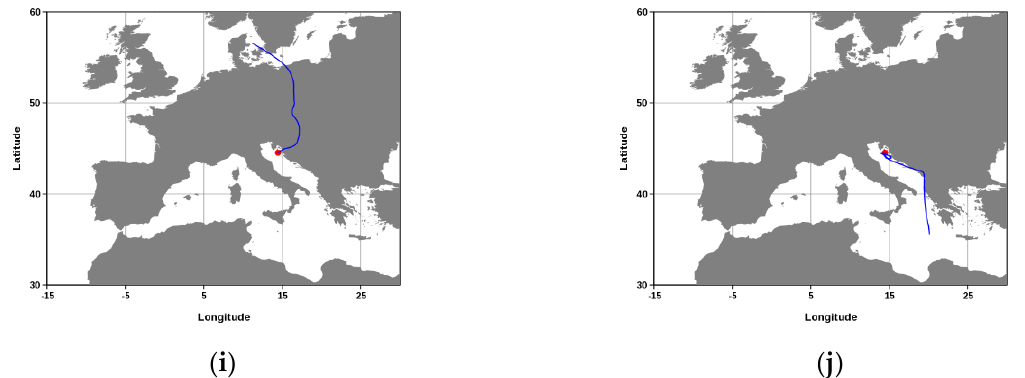
Figure 5. Air trajectories calculated for the Mali Lošinj observation site using METEX software and kinematic model. Calculations are carried on for the following days marked with letters: ( a ) 23 September 2004, ( b ) 22 October 2004, ( c ) 27 April 2005, ( d ) 25 May 2005, ( e ) 10 June 2005, ( f ) 15 July 2005, ( g ) 25 July 2005, ( h ) 19 August 2005, ( i ) 15 September 2005 and ( j ) 25 October 2005. Trajectories are calculated for 3 days backwards from the date mentioned above.